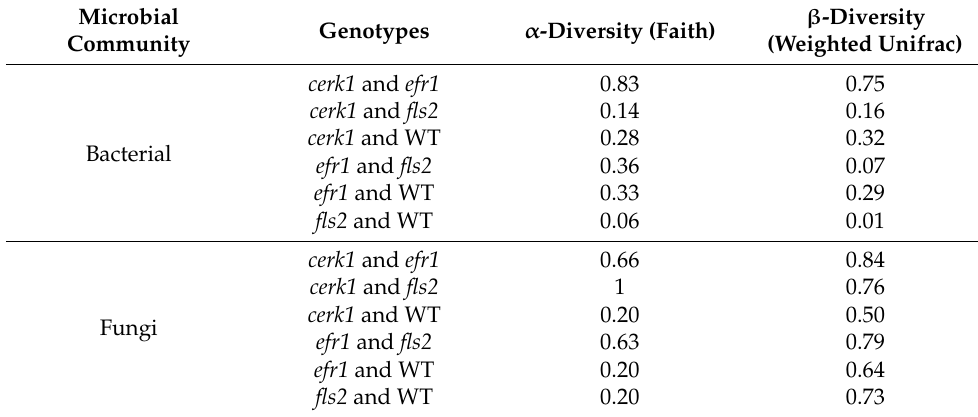
Figure 5. Histogram depicting α -diversity of the bacterial ( A ) and fungal ( B ) communities from rhizosphere of Arabidopsis PAMP mutants ( cerk1 , efr1 , and fls2 ) and the wild-type (WT; Col-0) grown in the Red River Farm soil (Table 1). Table 1. p- values of bacterial and fungal samples compared across different genotypes.